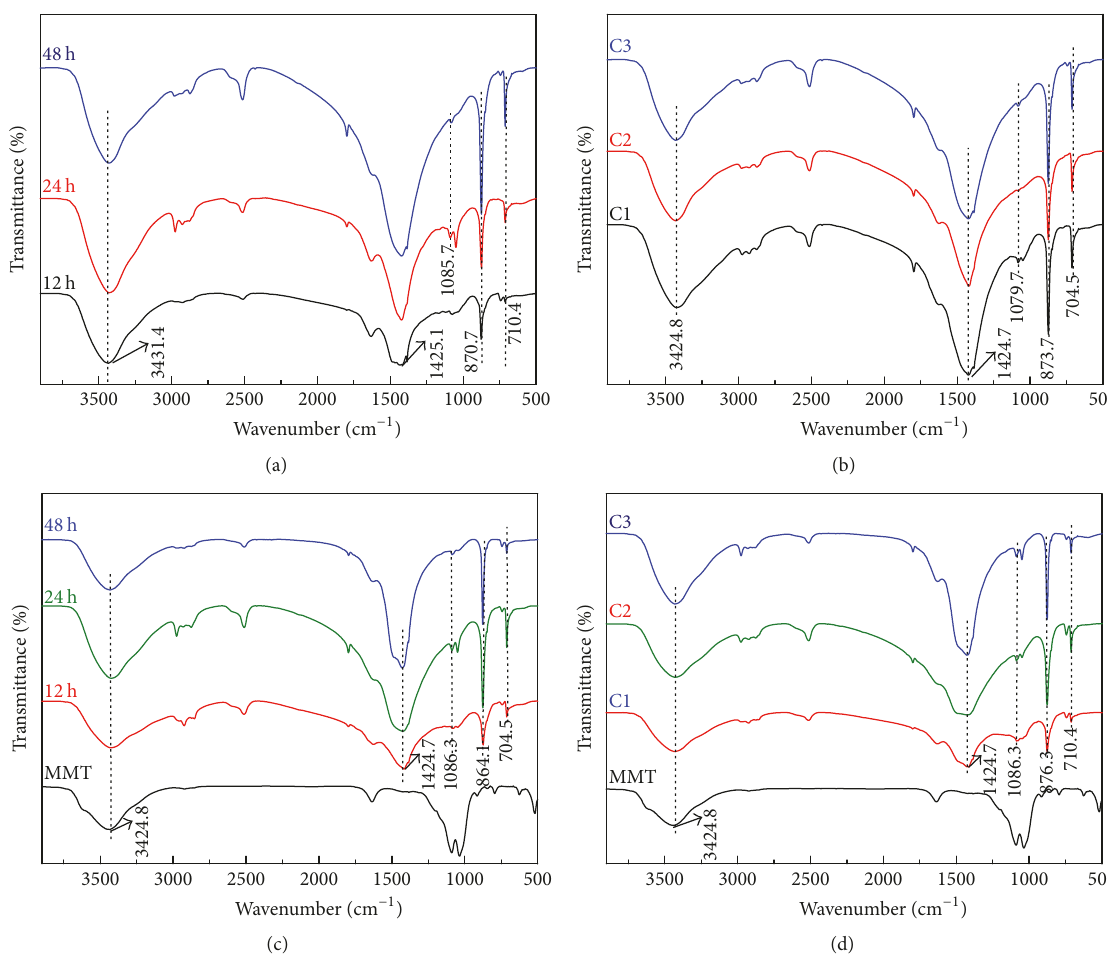
Figure 5: (a) FT-IR spectrum of mineralized samples b different Ca 2+ concentration without MMT, (b) FT-IR spectrum of mineralized samples by different time without MMT, (c) FT-IR spectrum of mineralized samples by different Ca 2+ concentration with MMT, and (d) FT-IR spectrum of mineralized samples by different time with